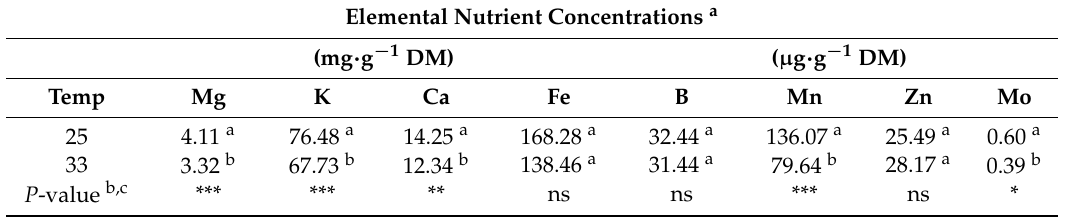
Table 2. The effect of growth chamber temperature on elemental nutrient concentrations of red, ‘Lollo’ lettuce.